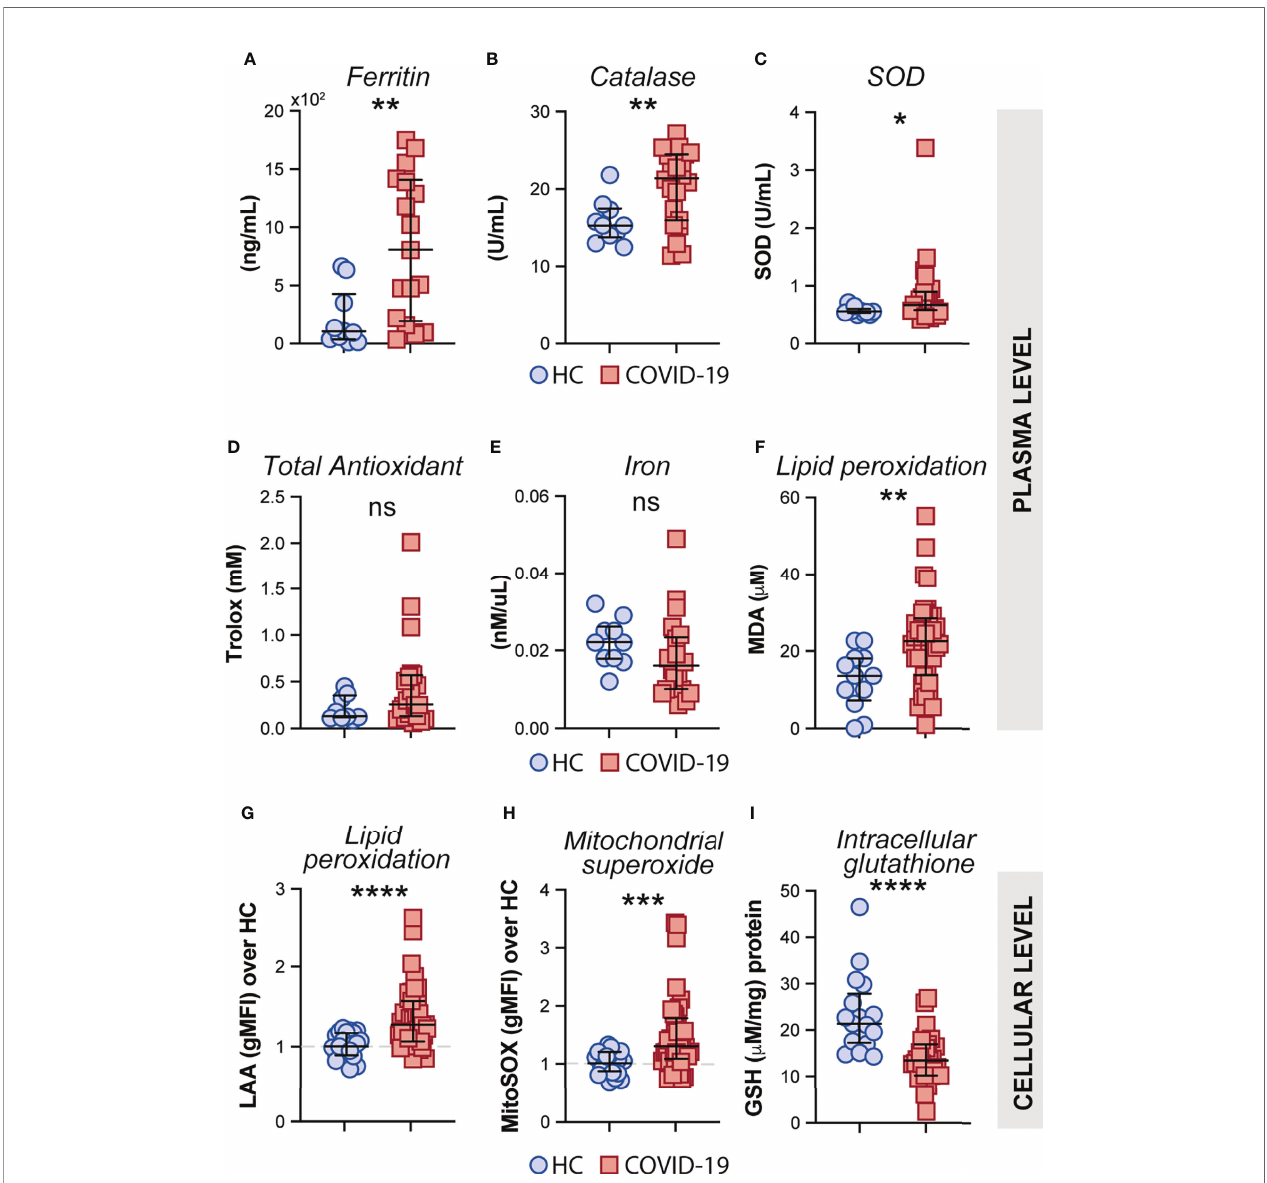
FIGURE 4 | Measures of oxidative stress in COVID-19 patients. Plasma levels of ferritin (A) , Catalase (B) , Superoxide dismutase (SOD) (C) , Trolox (D) Iron (E) and Lipid peroxidation (F) were compared between healthy control (HC) donors (n = 10 – 12) and COVID-19 patients (n = 20 – 40). Lipid peroxidation (LAA) (G) and mitochondrial superoxide (MitoSOX) (H) in CD14 high CD16 − monocytes was measured by fl ow cytometry in PBMC samples from HC (n = 22) and COVID-19 patients (n = 40). Data are expressed as the geometric mean fl uorescence intensity (gMFI) over average of HC. (I) Intracellular glutathione (GSH) levels in PBMC lysates from HC (n = 17) and COVID-19 patients (n = 27) were determined by analytic enzymatic assay as described in Materials and Methods . Data are presented as median values and interquartile ranges and analyzed using Mann – Whitney test. *P < 0.05, **P < 0.01, ***P < 0.001, ****P < 0.0001; ns , not signi fi